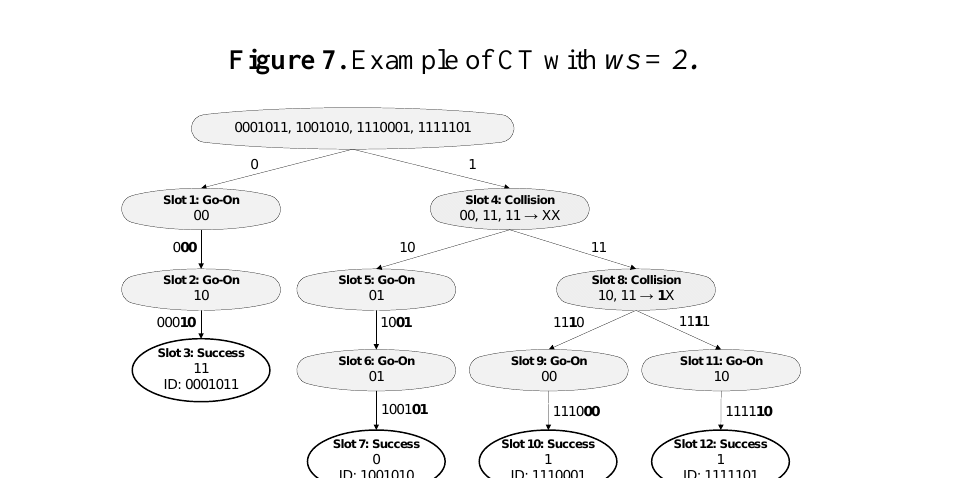
Figure 7. Example of CT with ws = 2.